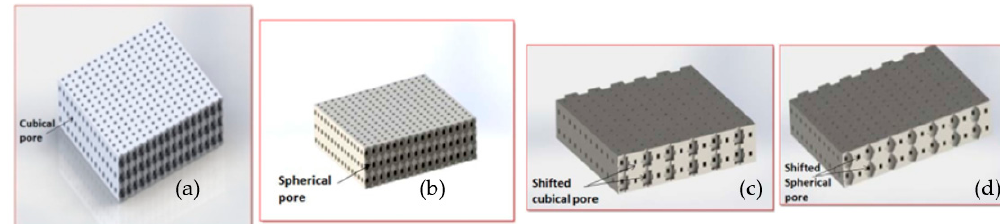
Figure 3. Four geometrics of porous scaffold that could be applied as base models. (a) Cubical pore model; (b) spherical pore model; (c) shifted cubical pore model; (d) shifted spherical pore model.